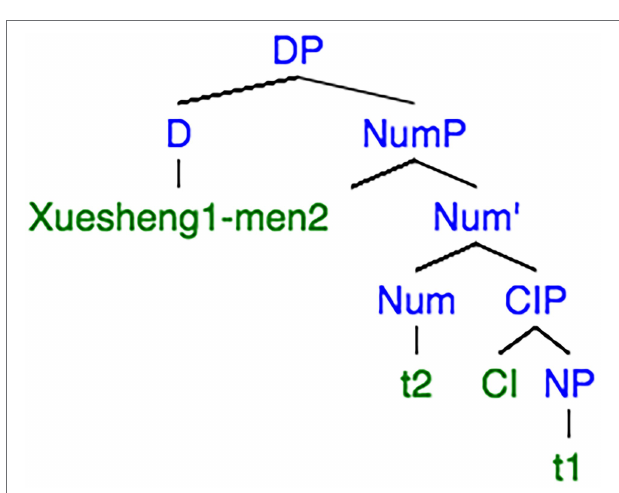
FIGURE 3 | Syntactic tree extracted from Zhang (2008, p.